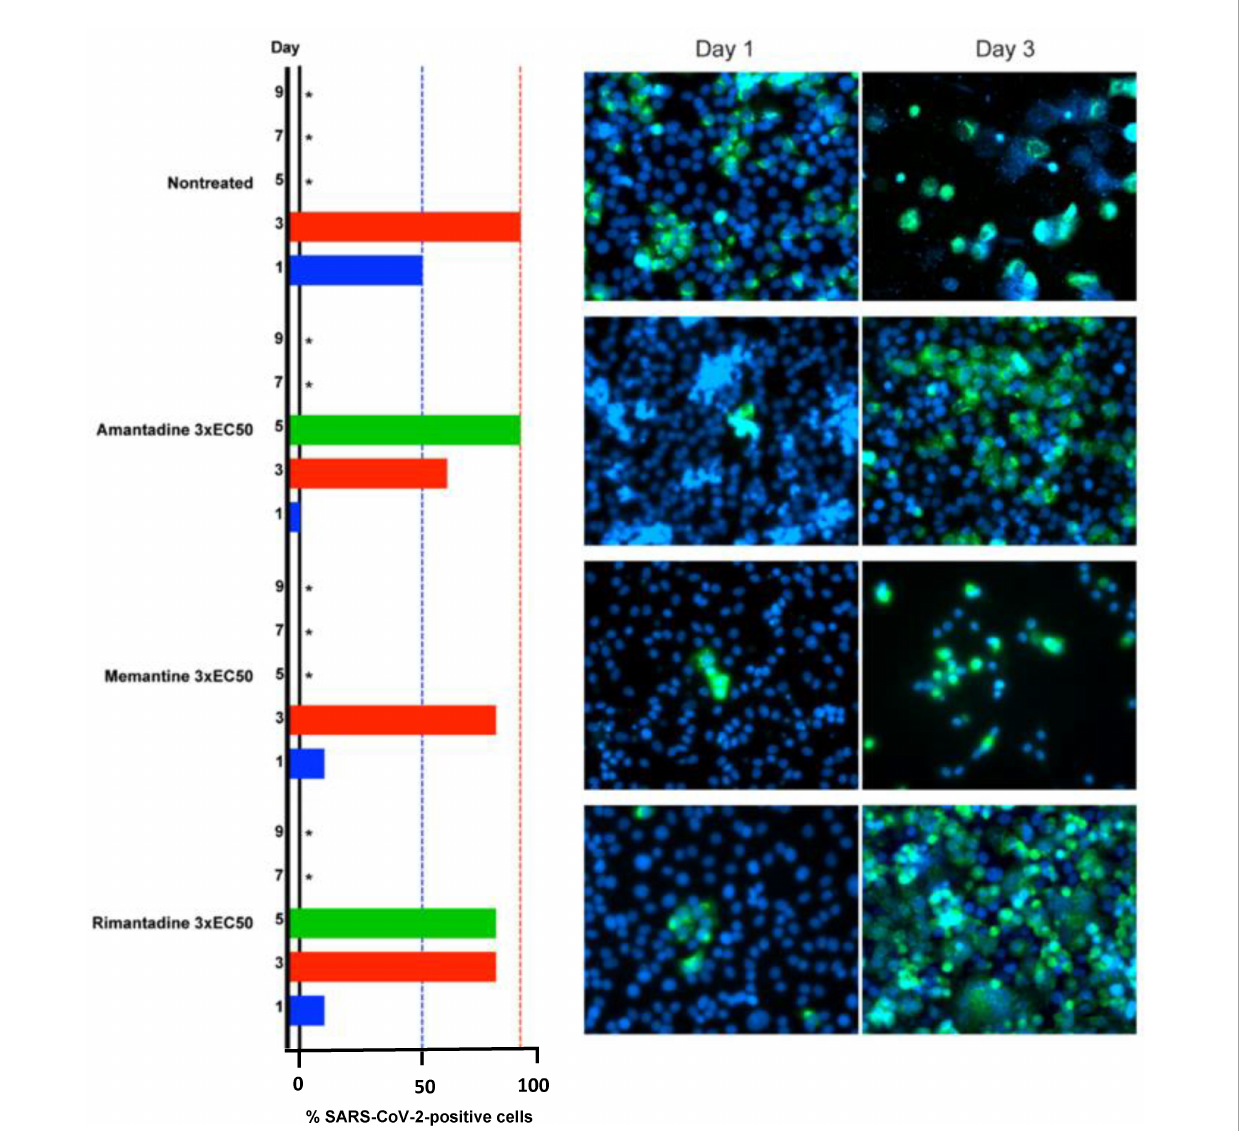
FIGURE3 Barrier to SARS-CoV-2 escape by memantine, amantadine and rimantadine in their roles as ion channel inhibitors in Vero E6 cells at concentrations of 3 x EC50 on days 1,3,5,7,9 post-infection. Infected cells identified by immunostaining for SARS-CoV-2 spike protein (green) relative to counterstaining of cell nuclei with Hoechst dye (blue). *Not recorded/cell